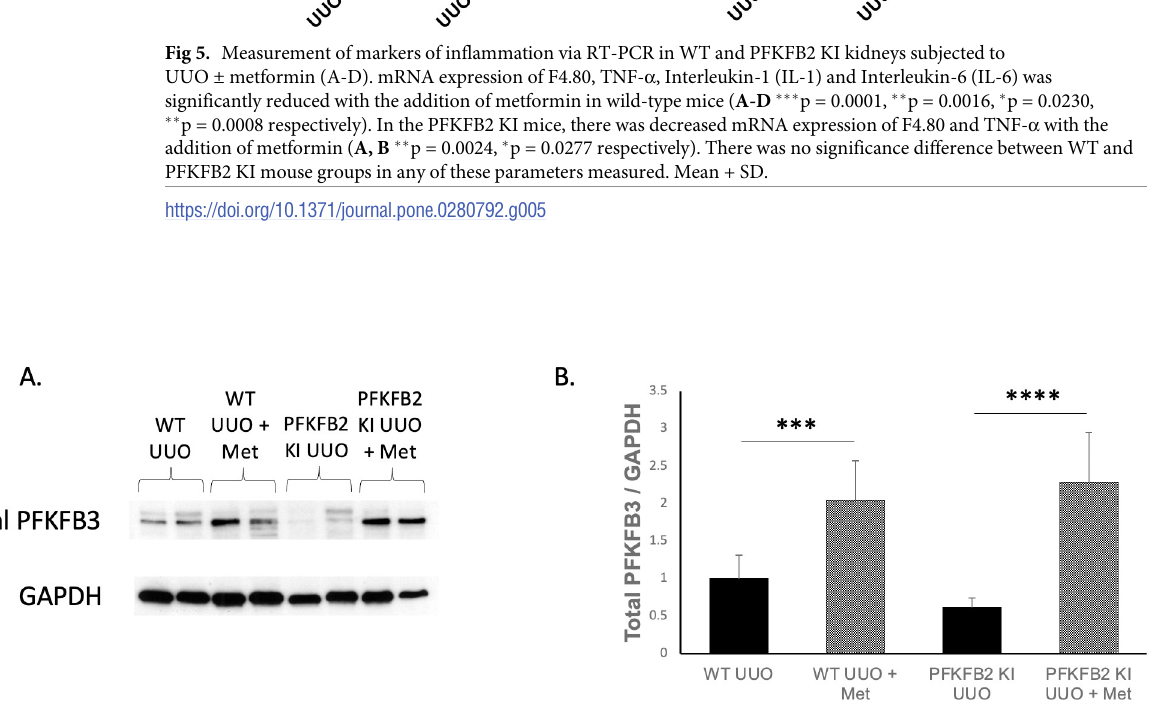
Fig 6. Measurement of Western blot expression of total PFKFB3 in whole kidneys for WT and PFKFB2 KI UUO ± metformin. Expression of Total PFKFB3 was increased in mice treated with metformin for both WT and PFKFB2 KI groups ( A, B ��� p = 0.0009, ���� p < 0.0001 respectively). Mean +